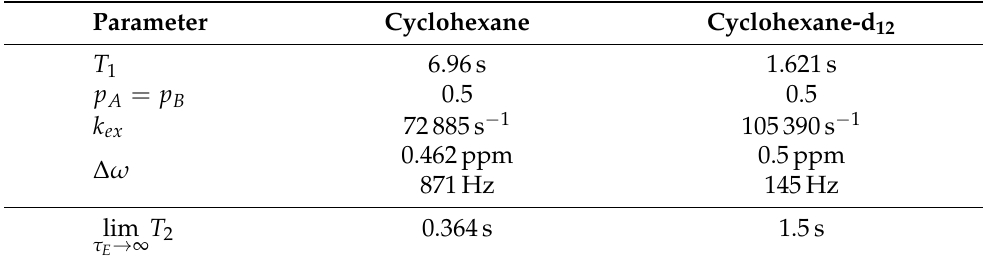
Table A4. Estimation of the short limit of T 2 of cyclohexane-h 12 /-d 12 in case of τ E → ∞ , according to Equation (A1). Since the asphaltene-free solution should fulfill the extreme narrowing limit, where T 1 = T 2 , T 2 A = T 2 B ≈ T 1 is assumed for the transverse relaxation time constants of the nuclei at the different sites. The exchange rates correspond to a sample temperature of ∼ 20°C and were taken from references [57] (C 6 H 12 ) and [58] (C 6 D 12 ) (determined for cyclohexane-h 12 /-d 12 in a solution of liquid crystals). The chemical shift differences were taken from references [54] (C 6 D 11 H at − 100°C) and [59] (neat plastic-crystalline C 6 D 12 at −